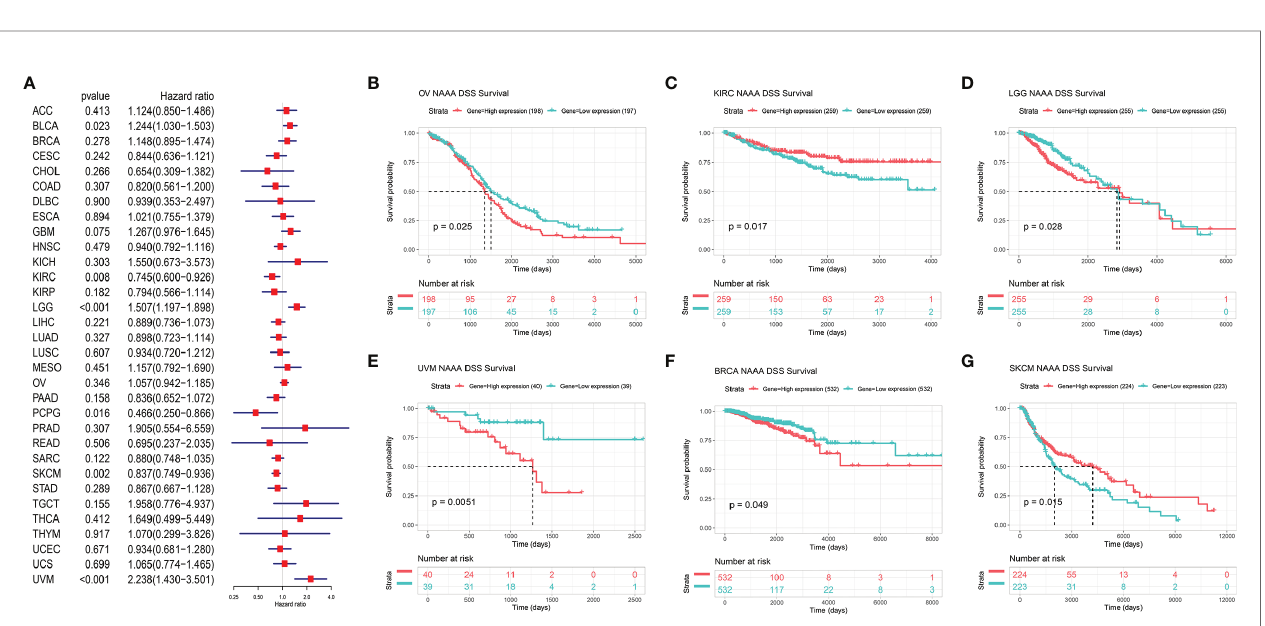
FIGURE 4 | Relationship of NAAA expression with patient Disease-Speci fi c Survival (DSS). (A) Forest map shows the univariate Cox regression analysis results for NAAA in TCGA pan-cancer samples. (B – G) Kaplan – Meier DSS curves of NAAA expression in the six most signi fi cantly associated tumors.